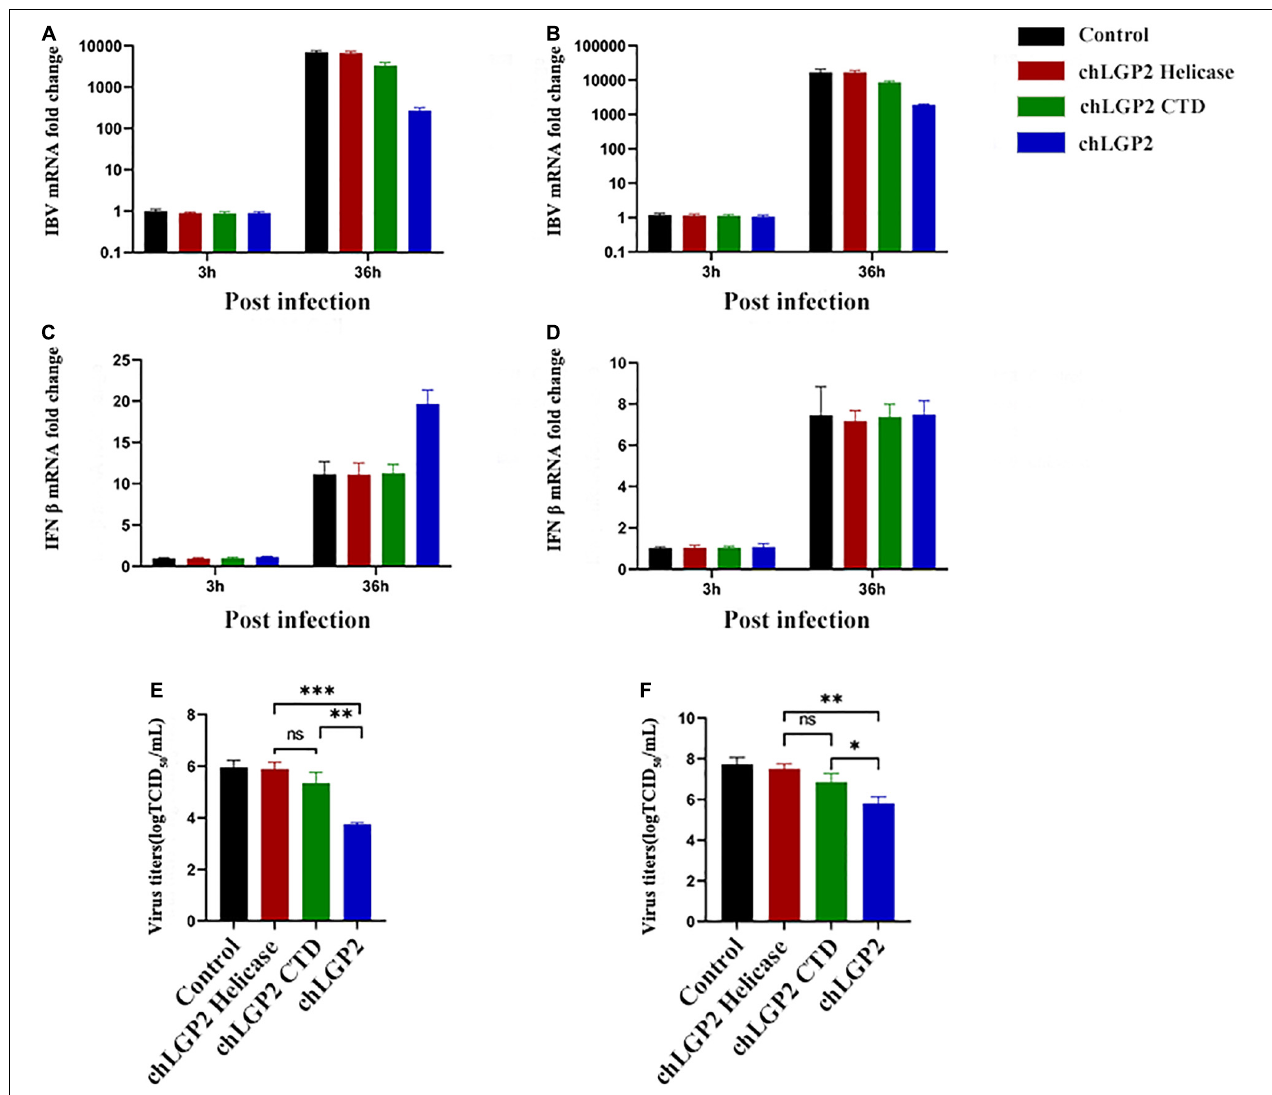
FIGURE 5 | The IBV inhibitory roles of chLGP2 domains in different cells. Compared with the helicase domain, the CTD domain of chLGP2 showed a certain inhibitory effect on IBV both in (A) HD11 and (B) DF-1 cells. (C) In HD11 cells, the individual domains of chLGP2 did not change the level of IFN- β , while in (D) DF-1 cells, the domains and the full chLGP2 showed almost the same effect. The CTD domain of chLGP2 inhibited the virus titer of IBV to a certain extent, both in (E) HD11 and (F) DF-1 cells. Data are the mean values of three independent experiments, and error bars denote mean ± SDM. ∗ P < 0.05; ∗∗ P < 0.01; ∗∗∗ P < 0.001; ns means not